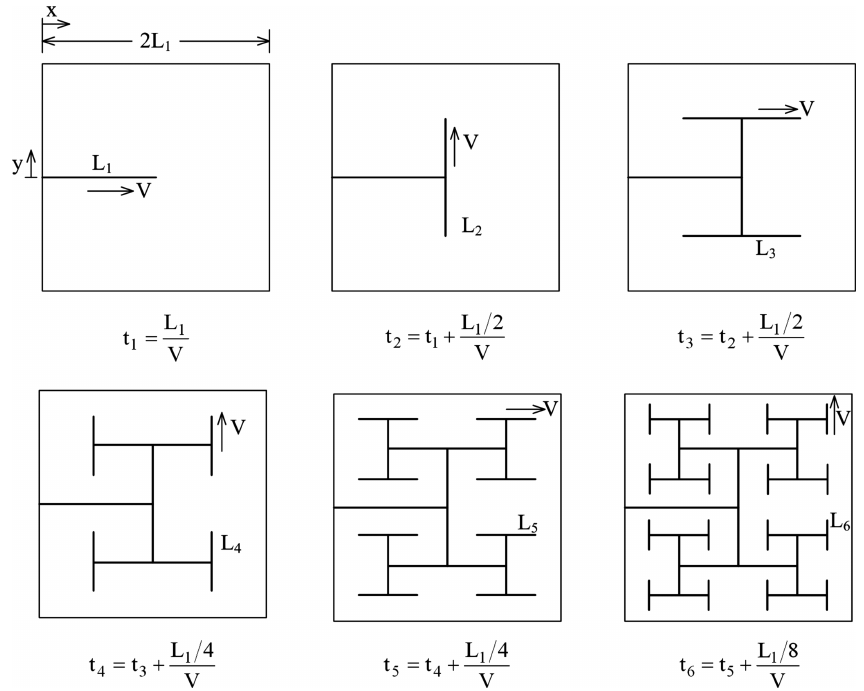
Figure 3: Tree-shaped line invasion of a conducting domain with assumed T - shaped